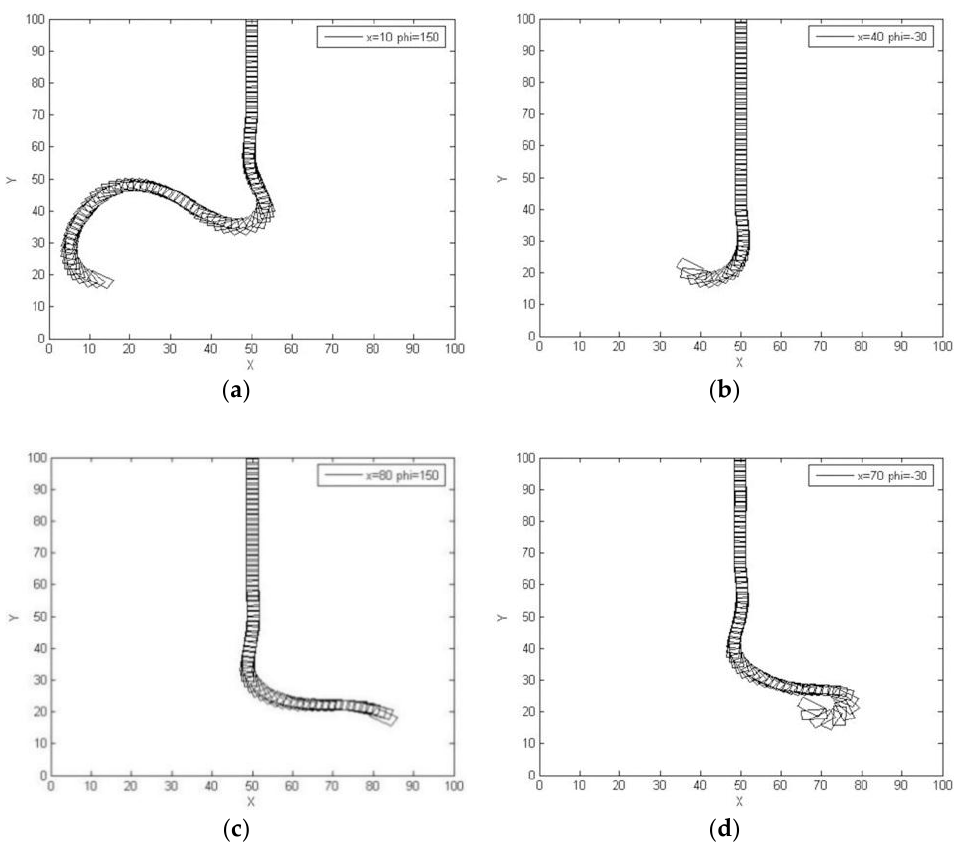
Figure 31. The moving car trajectories of the trained FNFN controller with the four different initial positions ( x , y , φ ) = ( a ) (10, 20, 150°), ( b ) (40, 20, −30°), ( c ) (80, 20, 150°), and ( d ) (70, 20, −30°). Table 4. The RMSE of a car backing control.